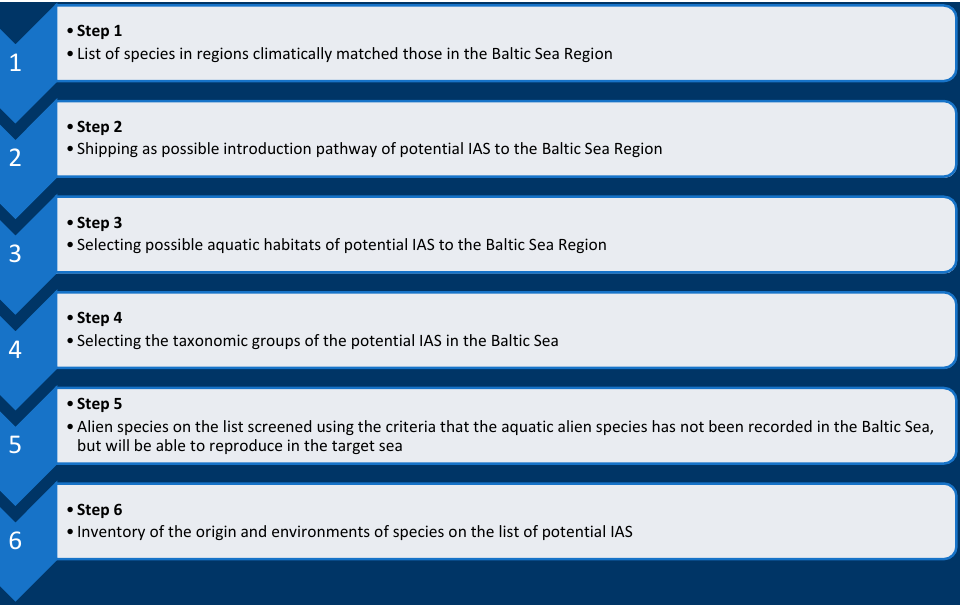
Figure 2. Processes involved in the horizon-scanning method considered at each step of the study.